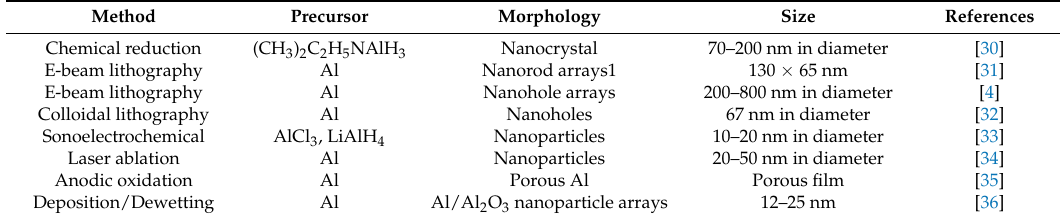
Table 1. Typical synthesis and fabrication methods of Al plasmonic